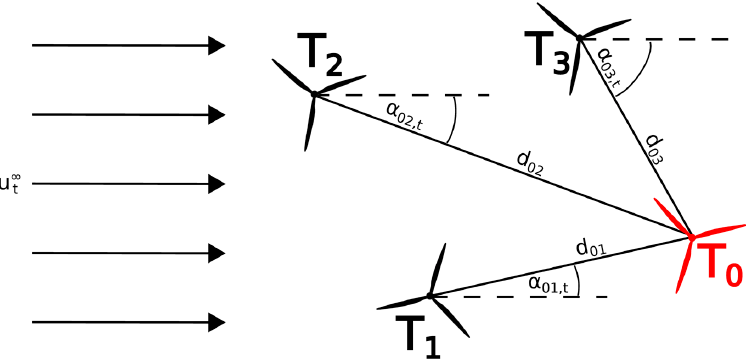
Figure 2. Definition of the distance and turbine alignment angle in the regression model.